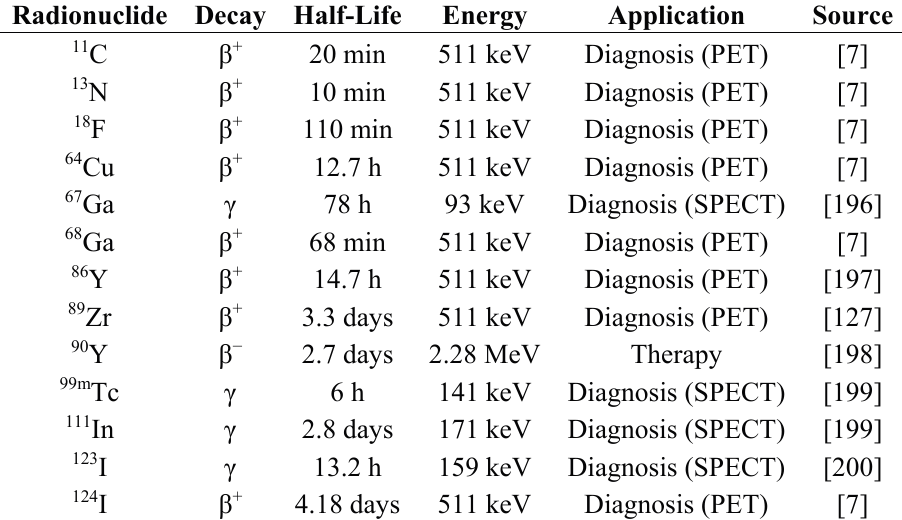
Table 3. Radionuclides used in